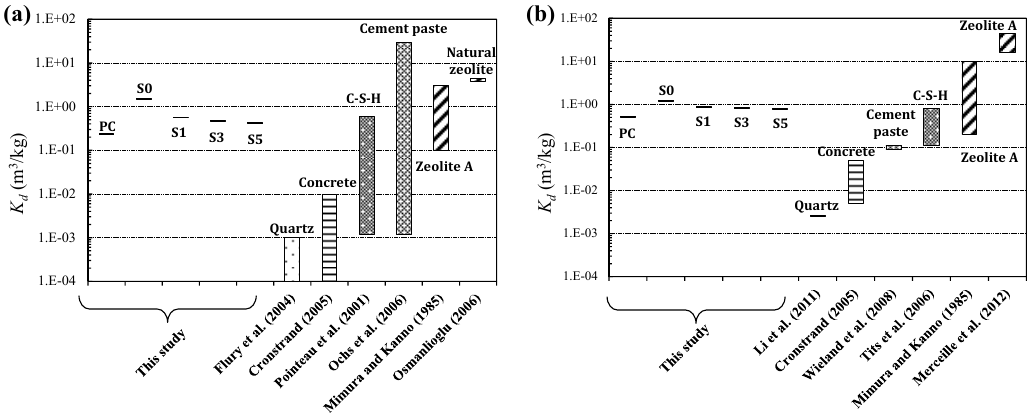
Figure 4. Compilation of K d values for ( a ) cesium and ( b ) strontium in this study and values from the literature.